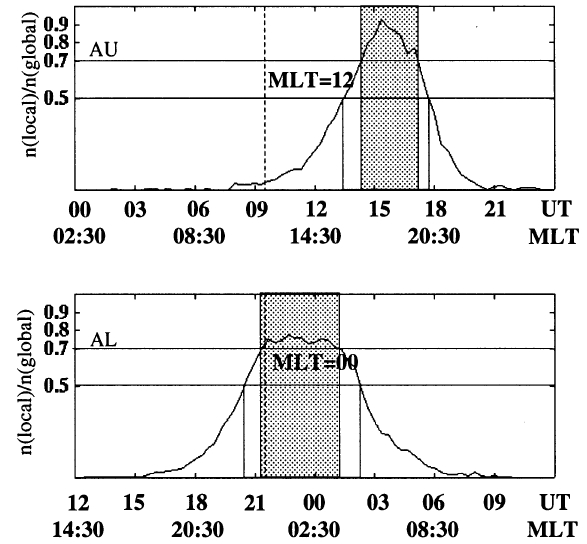
Fig. 3. Distribution of the local observations of A ” ( upper panel ) and A ‚ ( lower panel ) activity as functions of UT (or MLT). The gray shadings mark the UT-periods when the EISCAT Cross catches at least 70% of the activity events which the AE (12) chain records (for more details, see text)